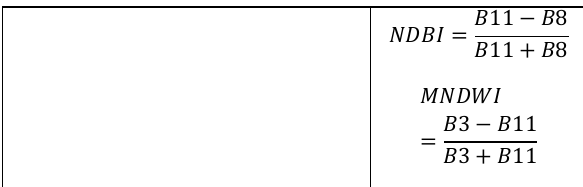
Table 1 . Sentinel-2 bands and spectral indices used in this